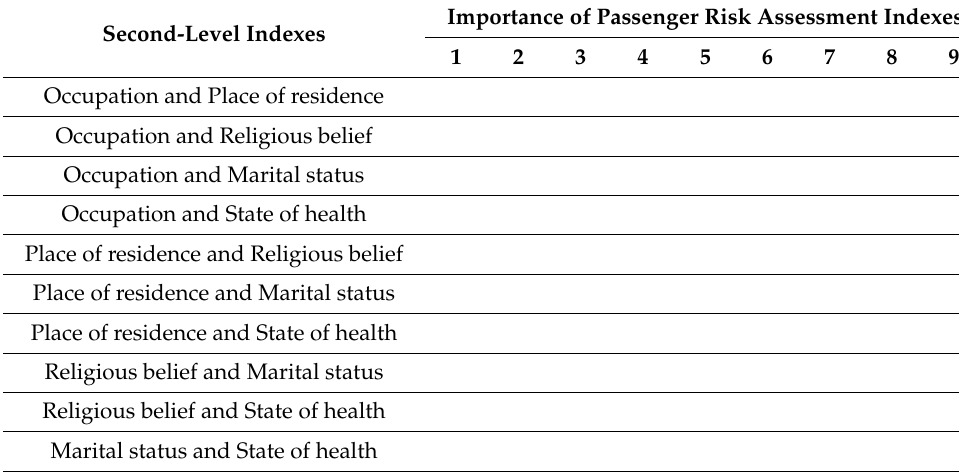
Table A3. Second-level indexes (personal